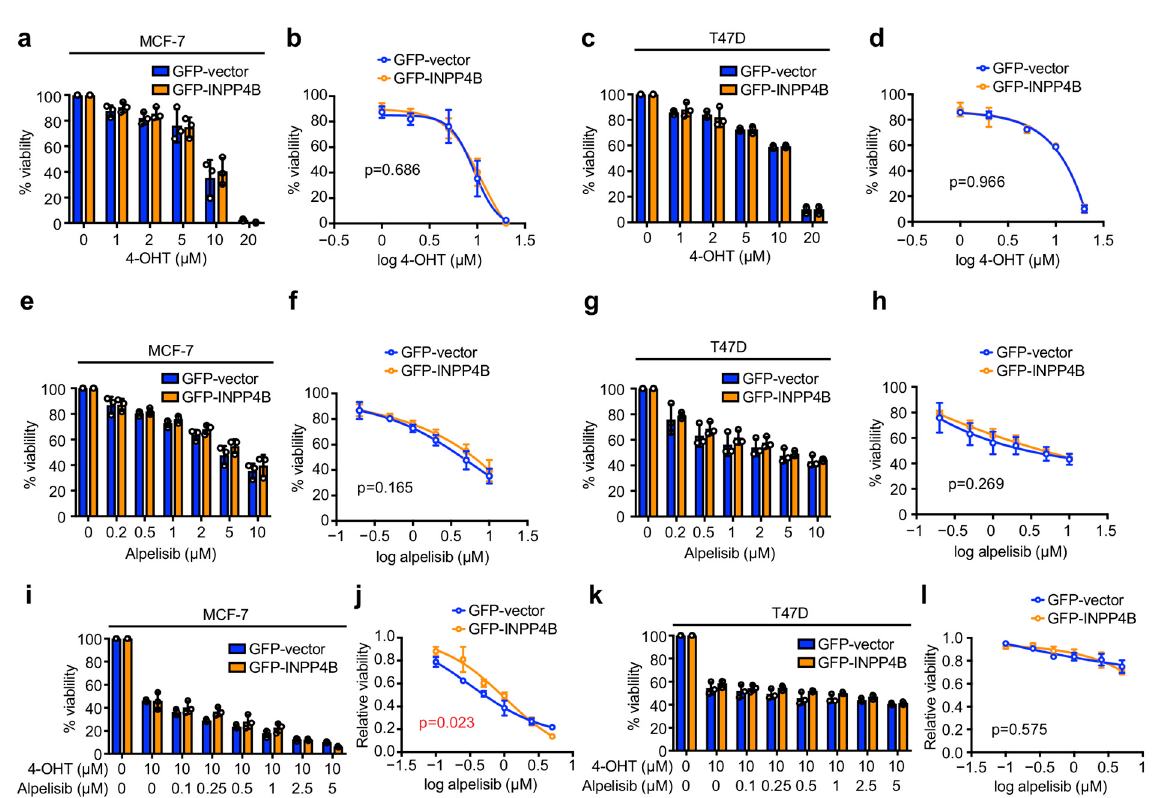
Figure 1. INPP4B overexpression has minimal effect on ER + breast cancer sensitivity to 4-OHT or alpelisib in monolayer culture. ( a – d ) MCF-7 ( a , b ) or T47D ( c , d ) cells expressing GFP-vector or GFP-INPP4B were treated with 1–20 µ M 4-OHT or DMSO as a vehicle control for 48 h, then cell viability was assessed using CellTiter-Glo ® assays. Data represent the relative cell viability normalized to untreated cells ( a , c ), or plotted as a 4-parameter logistical regression ( b , d ) ± SD ( n = 3 experiments). ( e – h ) MCF-7 ( e , f ) or T47D ( g , h ) cells expressing GFP-vector or GFP-INPP4B were treated with 0.2–10 µ M alpelisib or DMSO as a vehicle control for 48 h, then cell viability was assessed using CellTiter-Glo ® assays. Data represent the relative cell viability normalized to untreated cells ( e , g ), or plotted as a 4-parameter logistical regression ( f , h ) ± SD ( n = 3 experiments). ( i – l ) MCF-7 ( i , j ) or T47D ( k , l ) cells expressing GFP-vector or GFP-INPP4B were treated with 10 µ M 4-OHT and 0.1–5 µ M alpelisib or DMSO as a vehicle control for 48 h, then cell viability was assessed using CellTiter-Glo ® assays. Data represent the relative cell viability normalized to untreated cells ( i , k ), or plotted as a 4-parameter logistical regression normalized to 4-OHT-treated cells ( j , l ) ± SD ( n = 3 experiments). p values were determined by two-tailed unpaired t test of the area under the curve in ( b , d , f , h , j , l ). 3.2. INPP4B Increases ER + Breast Cancer Cell Sensitivity to Pyrvinium in Monolayer